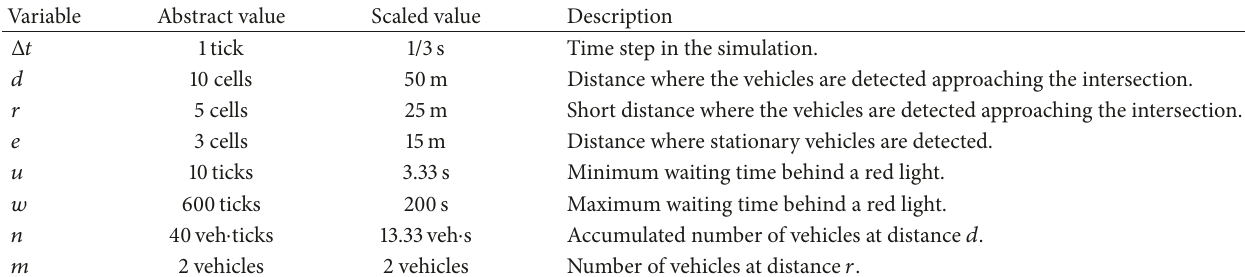
Table 1: Parameters used by the self-organizing method [4]. The size of each block is 80 meters.